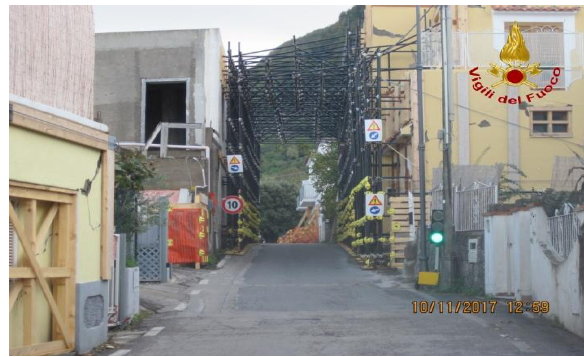
Figure 16. Bridge support structures